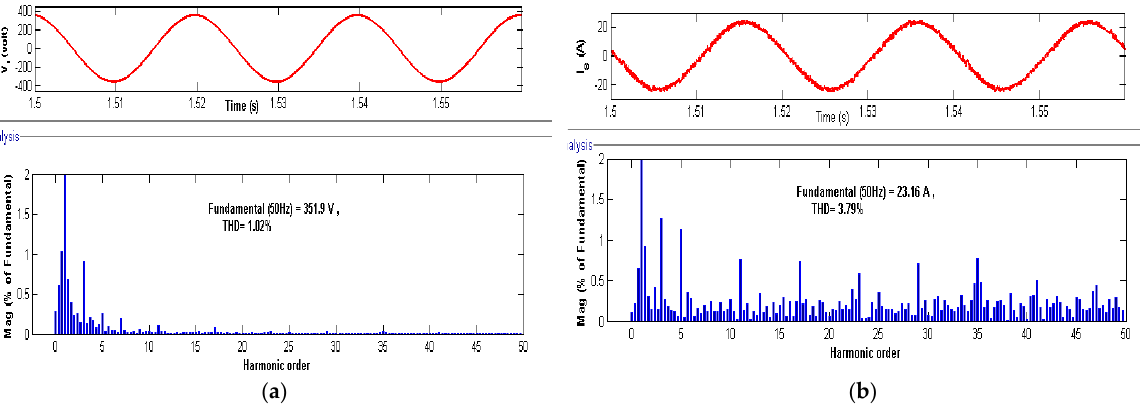
Figure 13. ( a ) THD in source voltage ( b ) THD in source current plotted against the harmonics.